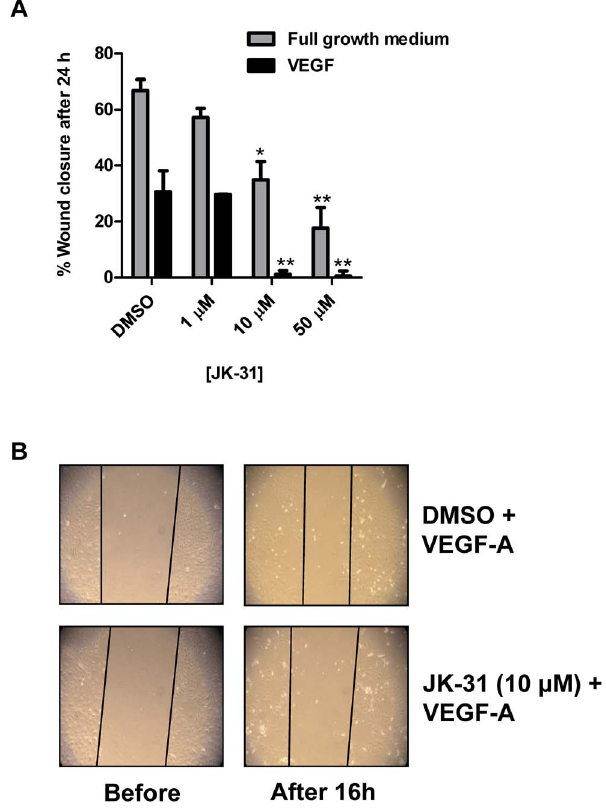
Figure 4. JK-31 inhibits endothelial wound closure invitro . (A) Scratch-wounded endothelial cell monolayers were incubated in either full growth medium (grey bars) or stimulated with 25 ng/ml VEGF-A (black bars) for 16 h in the presence of DMSO or JK-31 (1, 10 or 50 m M). Wounded cell monolayers were photographed before and after treatment and wound widths at each time point were measured using Image J software. Percentage wound closure was calculated by [(width before – width after)/width before] 6 100. Error bars represent 6 SEM (n=3; * p , 0.05; ** p , 0.01) for each condition. (B) Representative phase- contrast micrographs depicting wound closure over 16 h in the presence VEGF-A and either DMSO or JK-31 (10 m M).